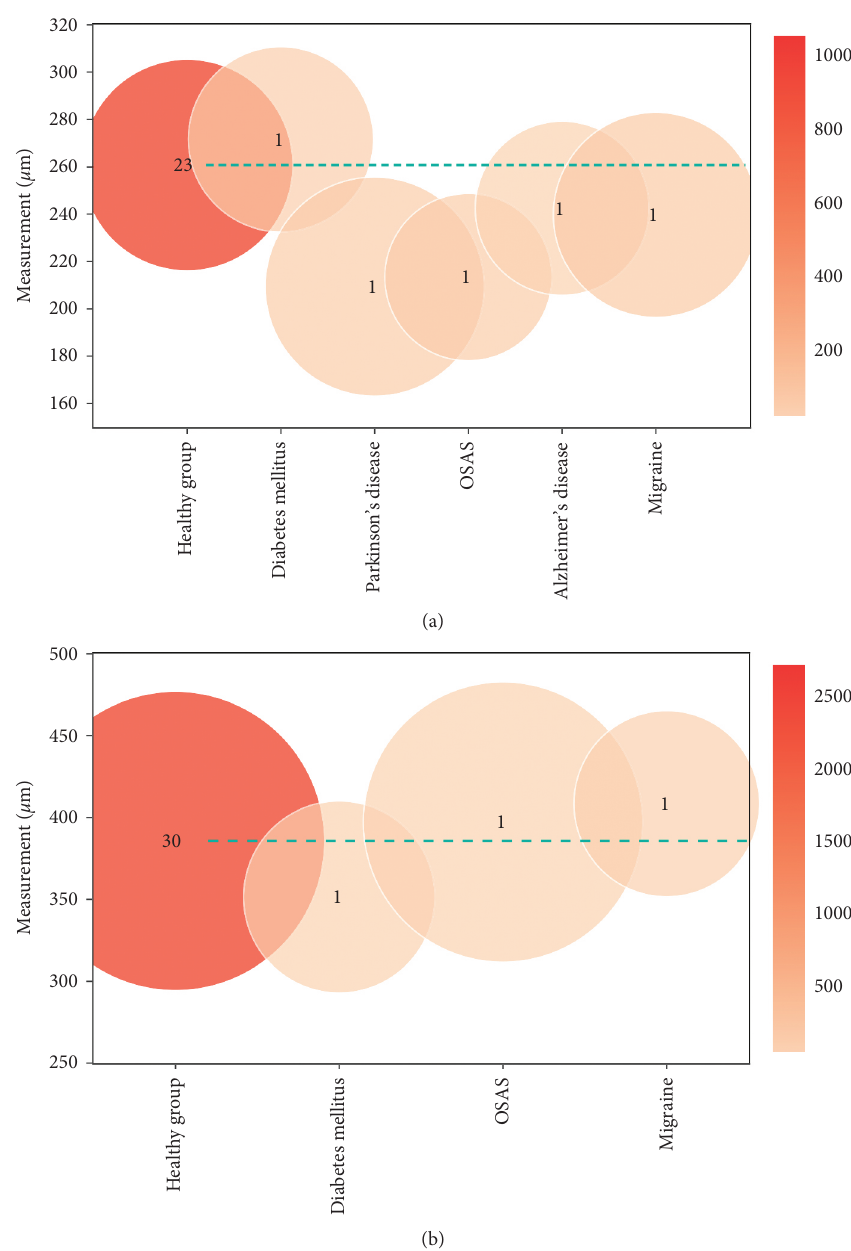
Figure 7: Comparison of lamina cribrosa (a) thickness (LCT) and (b) depth (LCD) for the nonophthalmic disease group. The green dashed line represents the mean for the healthy population. Only pathologies that included more than 20 eyes among all articles are considered for the